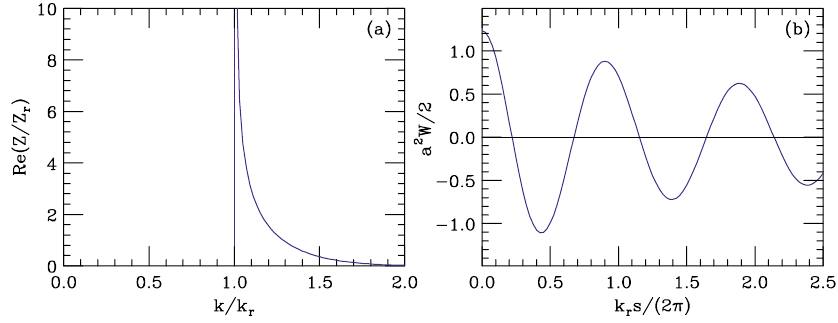
FIG. 3. (Color) For the case of two corrugated plates ( w ! 1 ): Re (cid:3) Z (cid:5) (a) and the wake (b), (cid:7) (cid:1)(cid:1)(cid:1)(cid:1)(cid:1)(cid:1)(cid:1)(cid:1)(cid:1)(cid:1)(cid:1)(cid:1)(cid:1)(cid:1)(cid:1)(cid:1)(cid:1)(cid:1) p= (cid:3) a(cid:8)g (cid:5) p and Z with k r